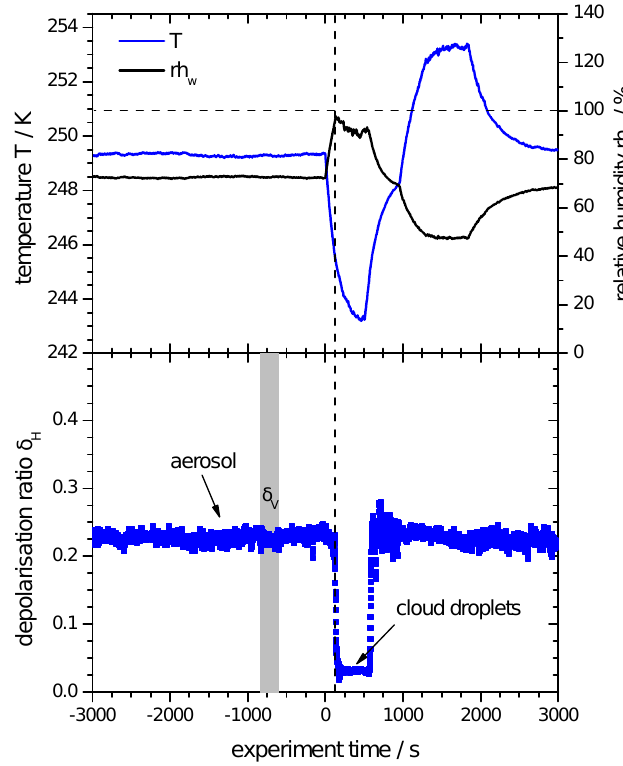
Fig. 8. SIMONE depolarisation evaluation experiment with syn- thetic hematite aerosol particles. At t = 0s, the spheroidal particles were activated to form spherical cloud droplets. A constant linear depolarisation ratio of 0 . 225 ± 0 . 006 was found for δ H and δ V out- side the cloud period which is in very good agreement with the mod- elled value of 0.22.